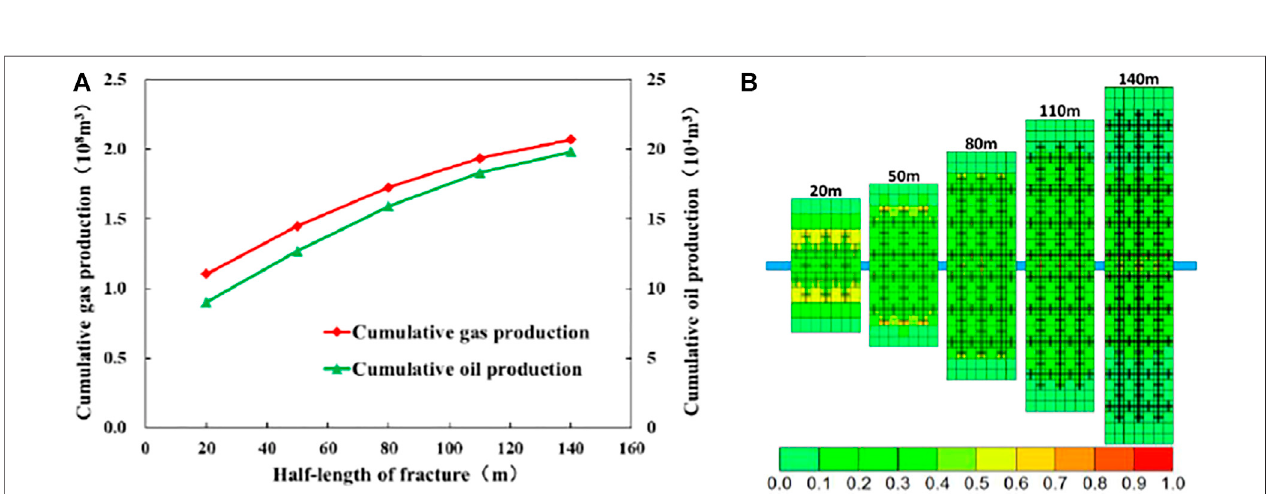
FIGURE 7 | Cumulative condensate and gas production curves (A) and condensate saturation distribution of fracturing segment (B) under different half-length of fracture.